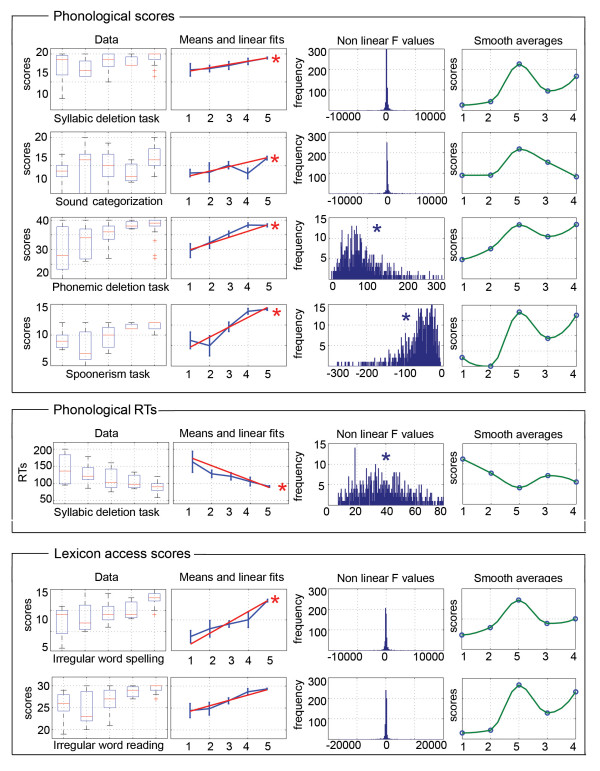
Illustration of subjects raw performances in the boxplots titled 'Data' (the red lines indicate the median, the blue boxes extend from the upper to the lower quartile values, the whiskers show the most extreme points within 1.5 times the inter-quartile range and the red plus signs indicate outliers) and bootstrapped performances with linear adjustments (graphic lines titled 'Means and linear fits'; vertical lines show the standard deviation of the bootstrapped means and the red lines the linear fits). Distribution plots titled 'Non linear F values' show the distributions of F values measuring the distances between the bootstrapped data and the bootstrapped regression lines. Non central distribution suggests non linear effects; significant effects are marked with a star. For 'Data' and 'Means and linear fits' graphics, groups are ordered by increasing/decreasing mean values: (1) LCD/LLN, (2) LCD/HLN, (3) HCD/HLN, (4) HCD/LLN, (5) Controls. By contrast, the last (right end side) graphics show the bootstrapped data (blue circles) with smoothed interpolated data (in green – piecewise cubic hermite interpolating polynomial). Best scores (controls) reflected an optimal in the volume distribution: low cerebellar volumes on the left (groups 1 and 2) and high cerebellar volumes on the right (3 and 4).